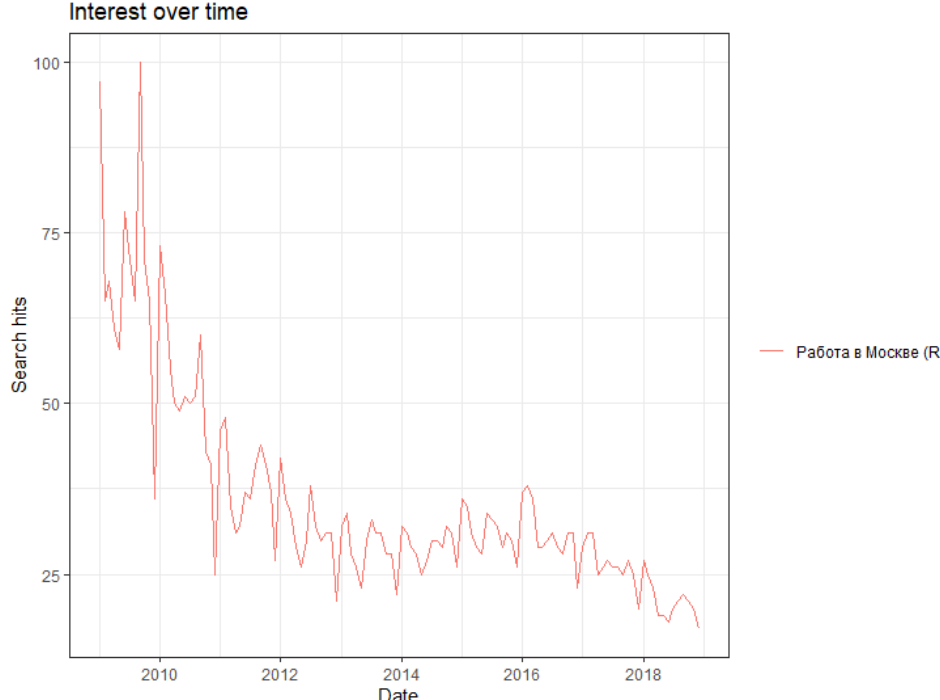
Figure A2. Google Trends data for the keywords “ Работа в Москве ”, searched in Russia. Sample: 1 January 2009–31 December 2018. Data downloaded using the gtrendsR package.